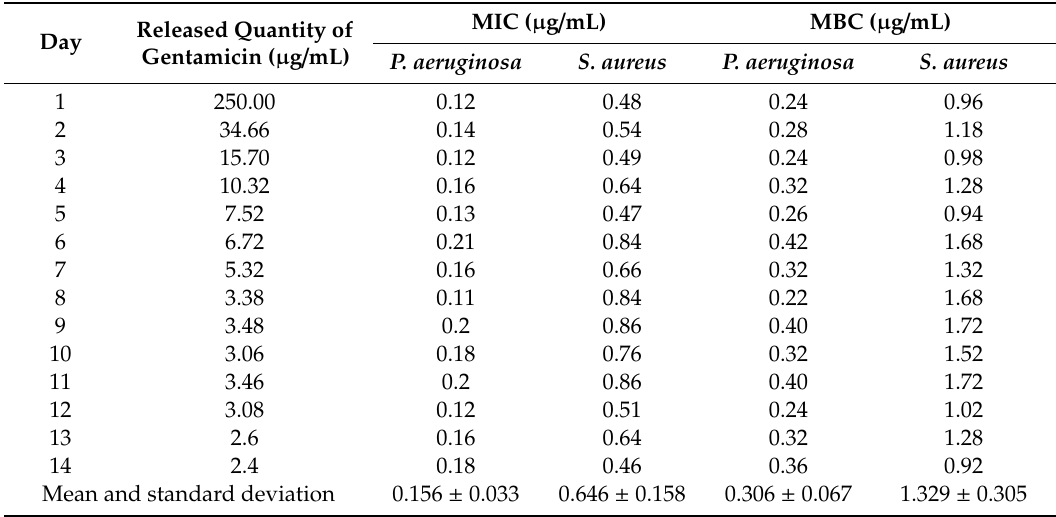
Table 4. Daily determination of MIC and MBC for the extracts obtained from pill